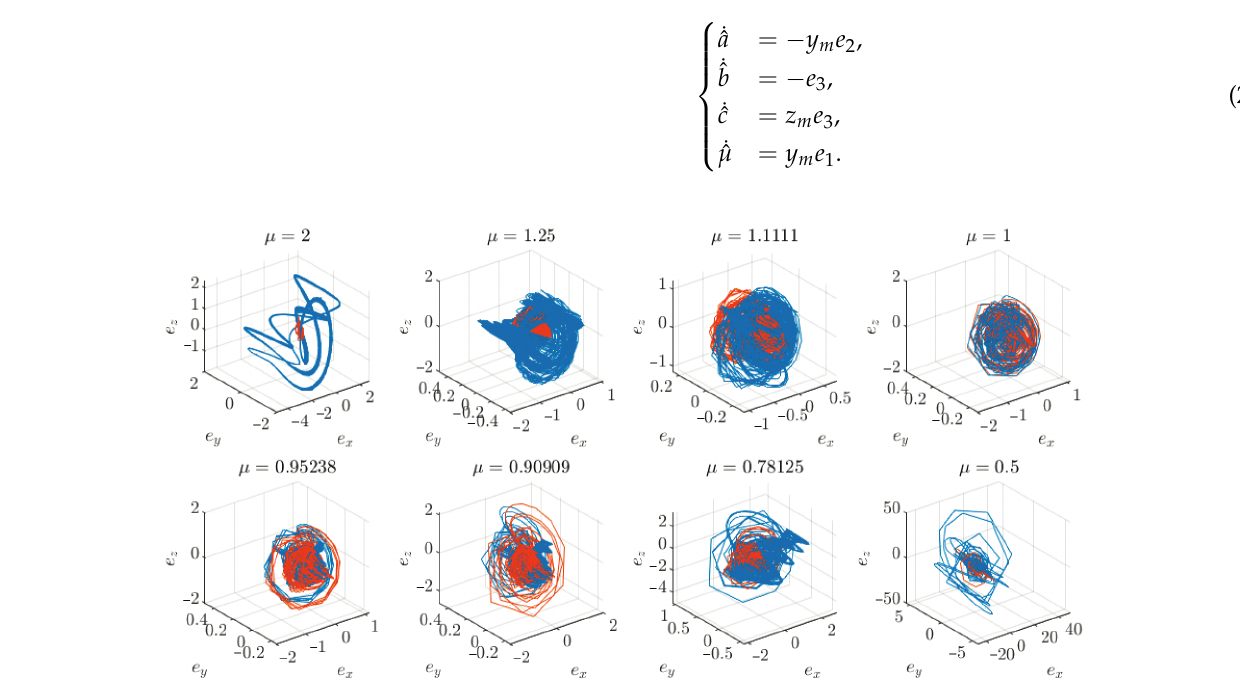
Figure 13. Error attractors between the circuit and the computer model: blue for the slave system (12) and red for the slave system